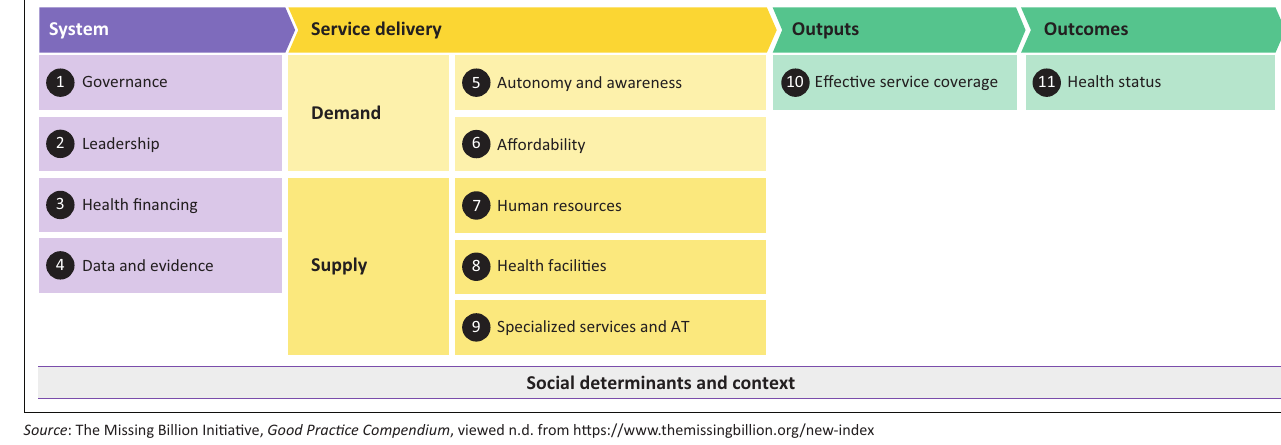
FIGURE 1: Preliminary framework of inclusive health